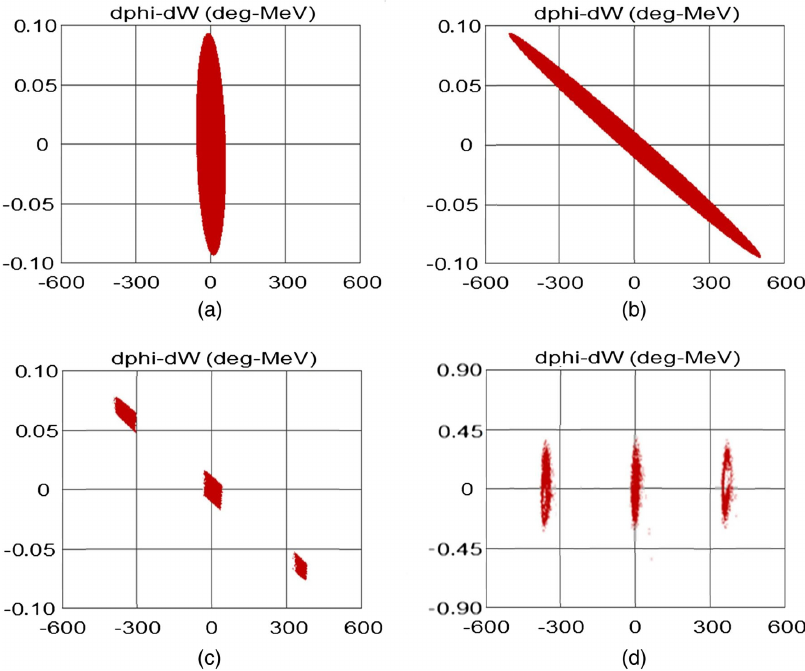
FIG. 4. Computed longitudinal phase space plots: (a) injector exit, (b) SCDTL-1 input, (c) coordinates at SCDTL-1 input of the particles transmitted up to the SCDTL-4 exit, and (d) SCDTL-4 exit.